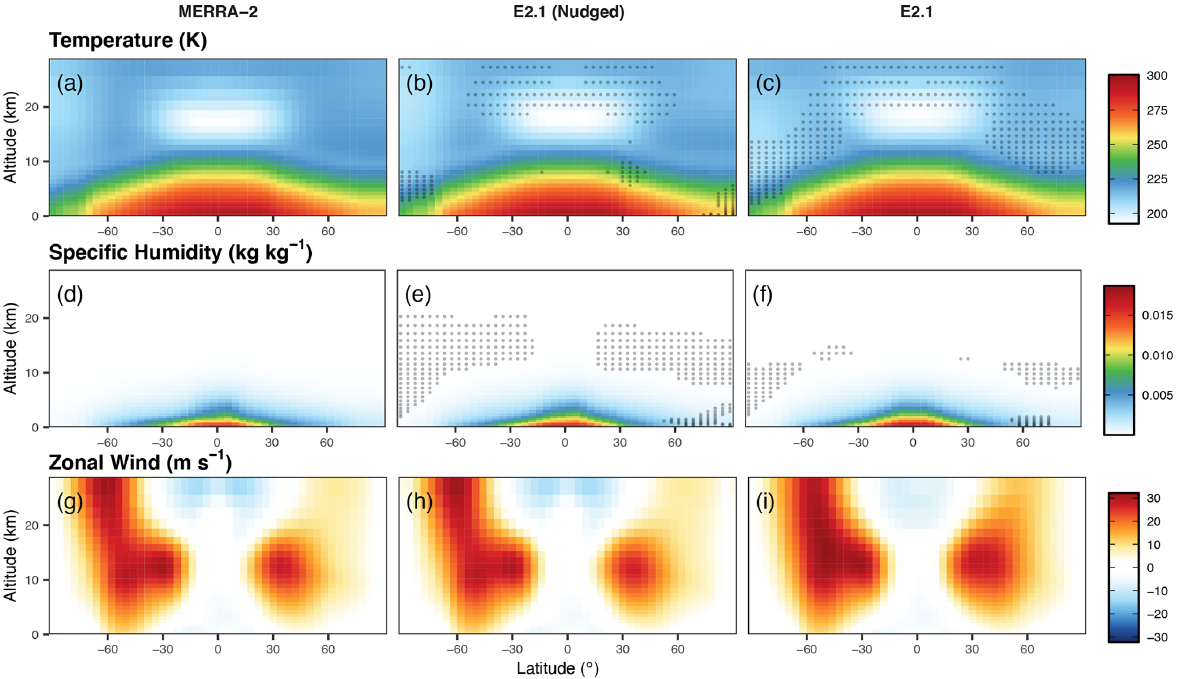
Figure 5. Comparison of present-day zonal meteorology. Columns from left to right show annual climatological zonal means for 2005– 2014CE in the MERRA-2 reanalysis, our E2.1 simulations with winds nudged to MERRA-2, and our free-running E2.1 simulations. From top to bottom, rows show air temperature in K, specific humidity in kgkg − 1 , and the zonal wind component in ms − 1 . Gray dots show where the two E2.1 simulations are statistically different from their MERRA-2 counterparts with respect to interannual variability ( p value < 0.05; n = 10 years).